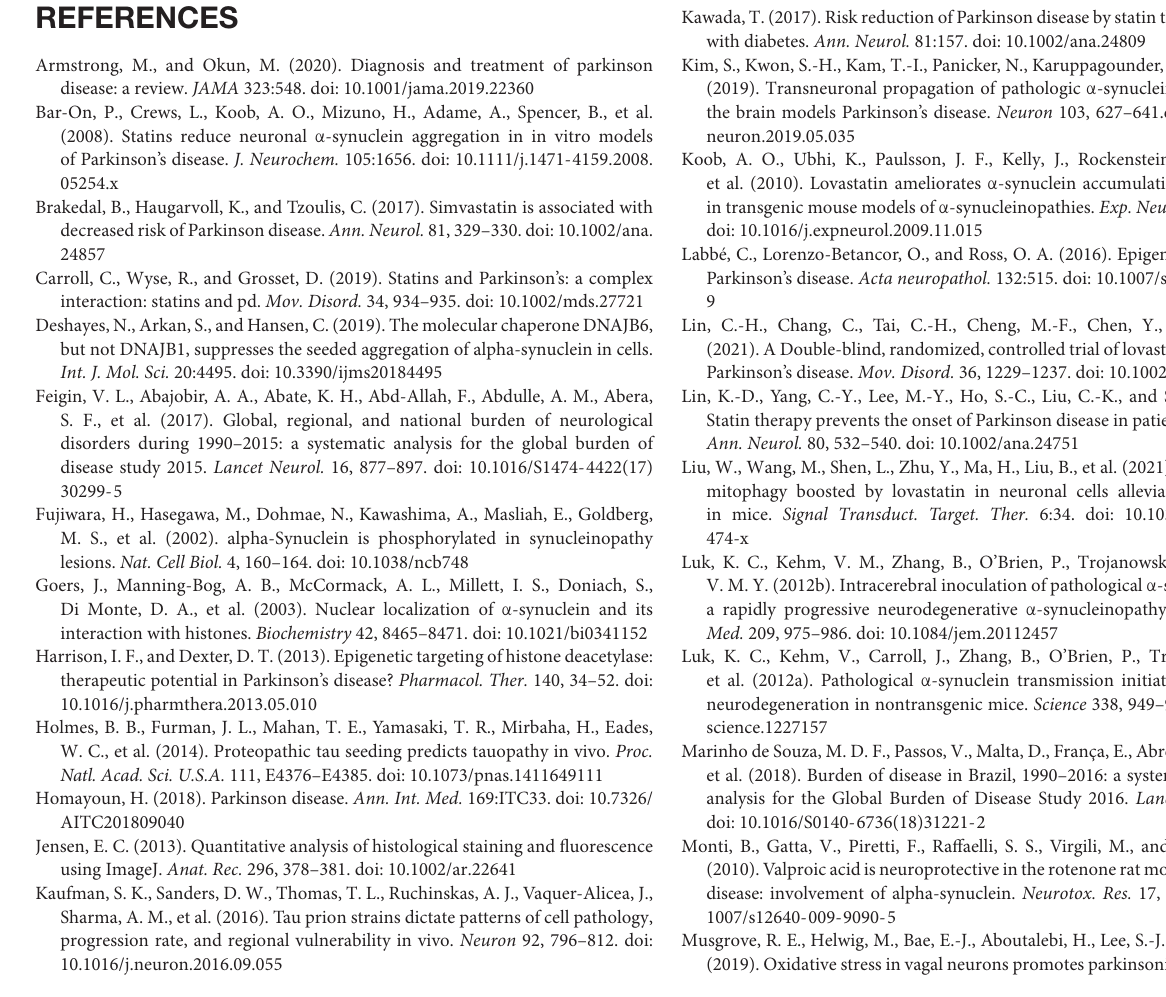
Supplementary Figure 1 | (A) Immunofluorescence showing the presence of exogenous his- α -syn PFFs in cells. (B) Quantification of his- α -syn PFFs in cells. All data are means ± SEM, ns: not statistically significant, one-way ANOVA with Tukey’s multiple comparisons test. All experiments were performed in triplicate for at least three independent times. Supplementary Figure 2 | Quantitative detection of GRK5 activity. All data are means ± SEM, ns: not statistically significant, one-way ANOVA with Tukey’s multiple comparisons test. All experiments were performed in triplicate for at least three independent